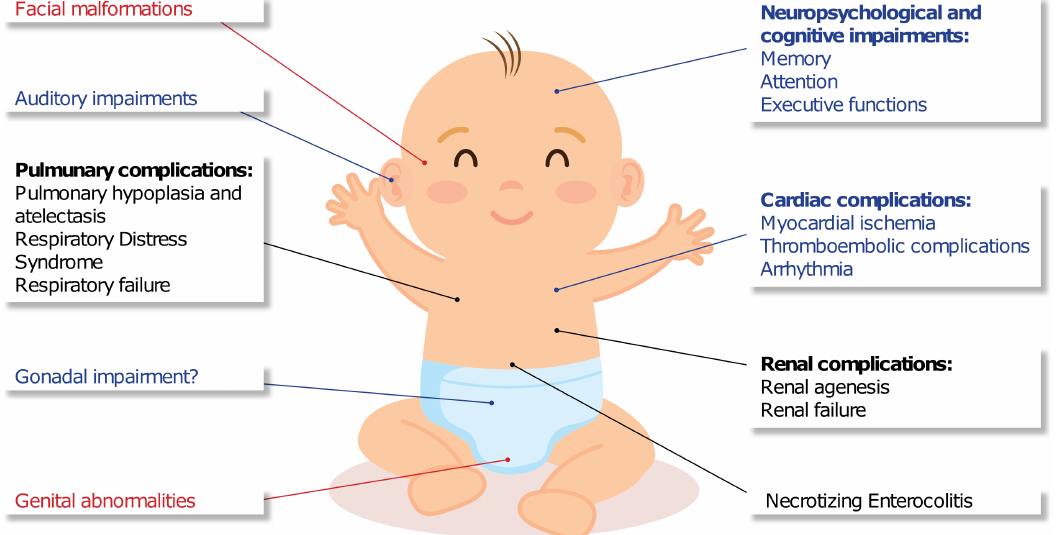
Figure 3. Possible documented neonatal outcomes following in-utero exposure to hormonal therapy (red) [65], targeted therapy (black) [72], and chemotherapy-related long-term outcomes (blue)